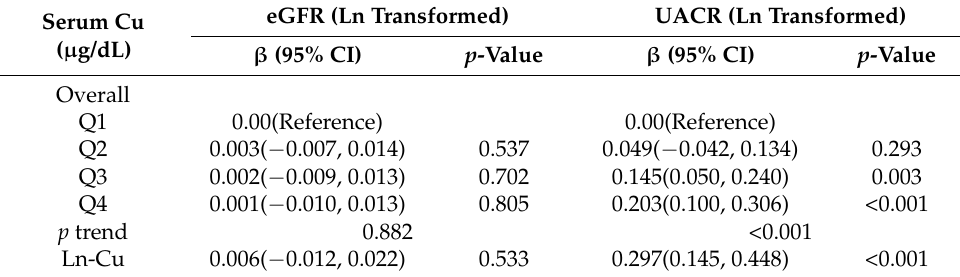
Table 2. Overall association of serum Cu with kidney function indicators.